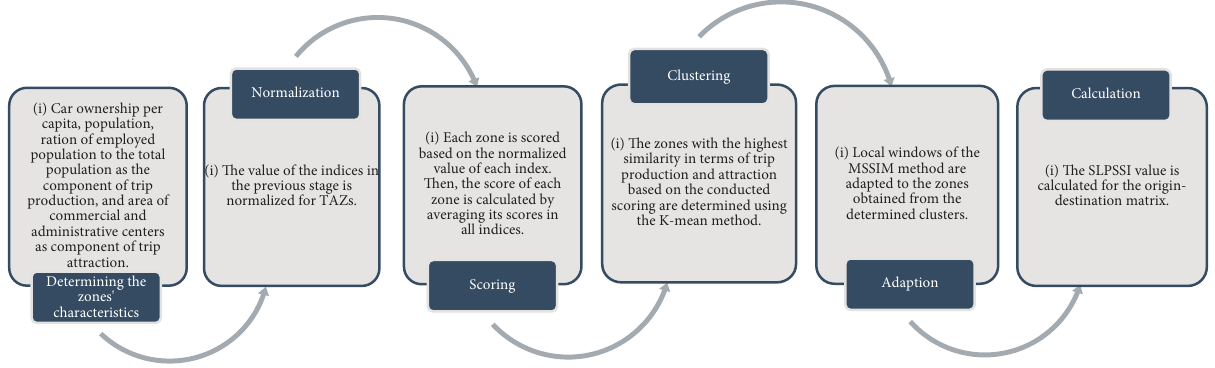
Figure 5: Flowchart of the suggested